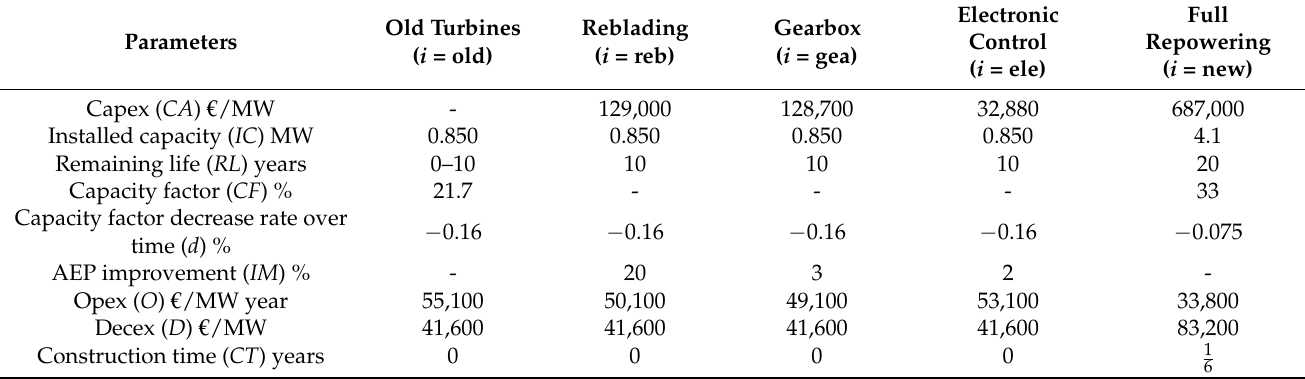
Table 10. Parameters for all